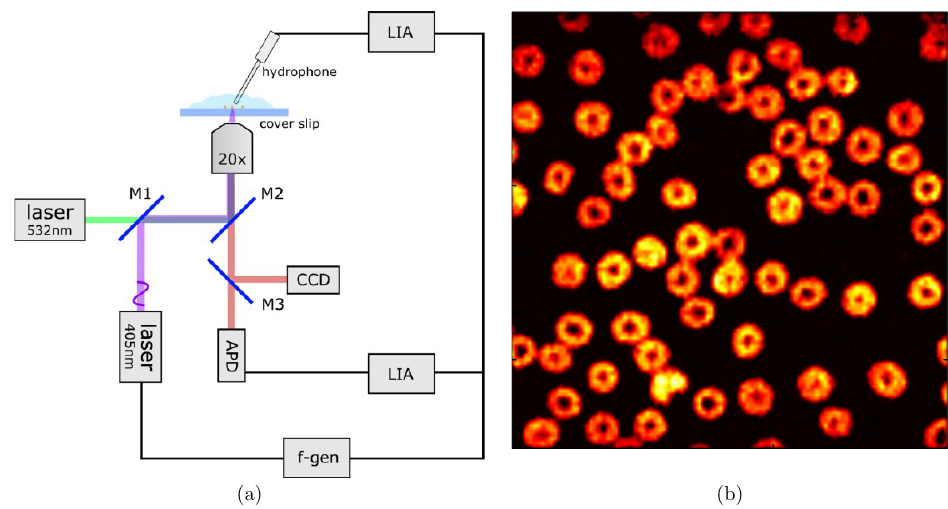
Fig. 9. (a) Simpli¯ed schematics of the CW LD-PAM setup, (b) photoacoustic image of red blood cells, (c) photoacoustic image on microspheres, (d) °uorescence image of (c), and (e) overlay of (c) and (d) (images adapted from Ref.